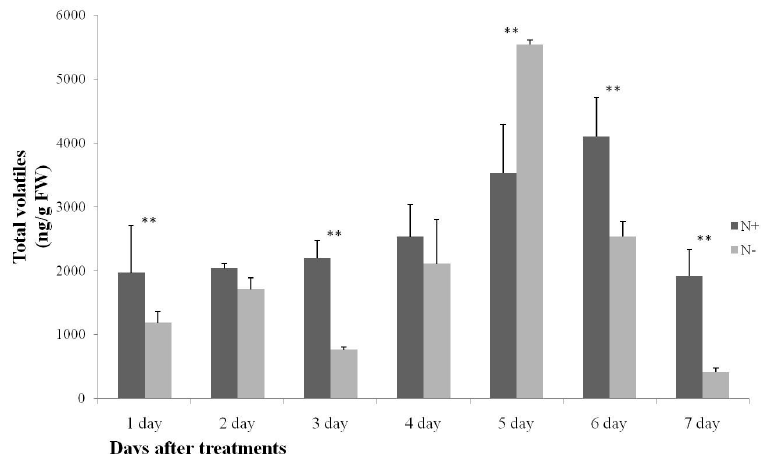
Figure 1. Changes of total volatile content in 9930 leaves during N-sufficient and N-deficient treatments. N+ and N − mean nitrogen sufficient and nitrogen deficient treatments, respectively. Bars present means ± standard deviations, data were analyzed by one-way ANOVA followed by the Duncan’s multiple range tests to make comparisons within both treatments in same day. Asterisks indicate significant difference, ** p < 0.01. Values are means of three replicates.